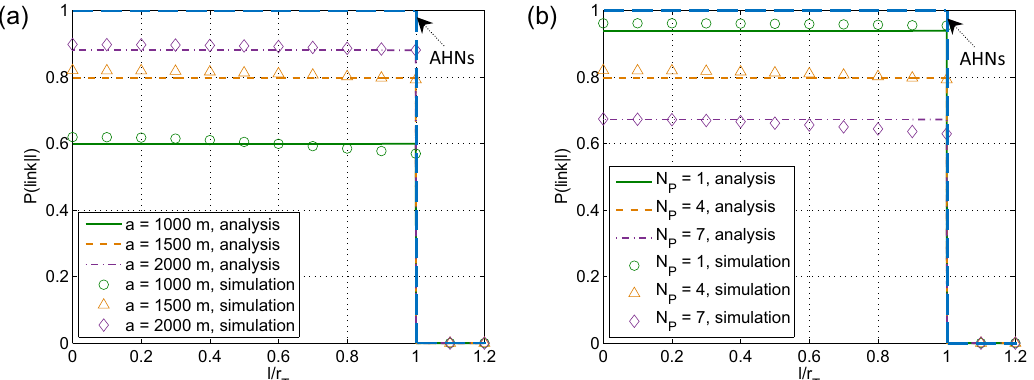
Figure 8. Link connectivity between two nodes versus the relative distance between them for different ( a ) network size a and ( b ) the number of PU-Tx-PU-Rx pairs. N S = 300, λ P = 0.3, R T = r T = 250 m, R I = r I = 280 m; N P = 4 for ( a ) and a = 1500 m for ( b